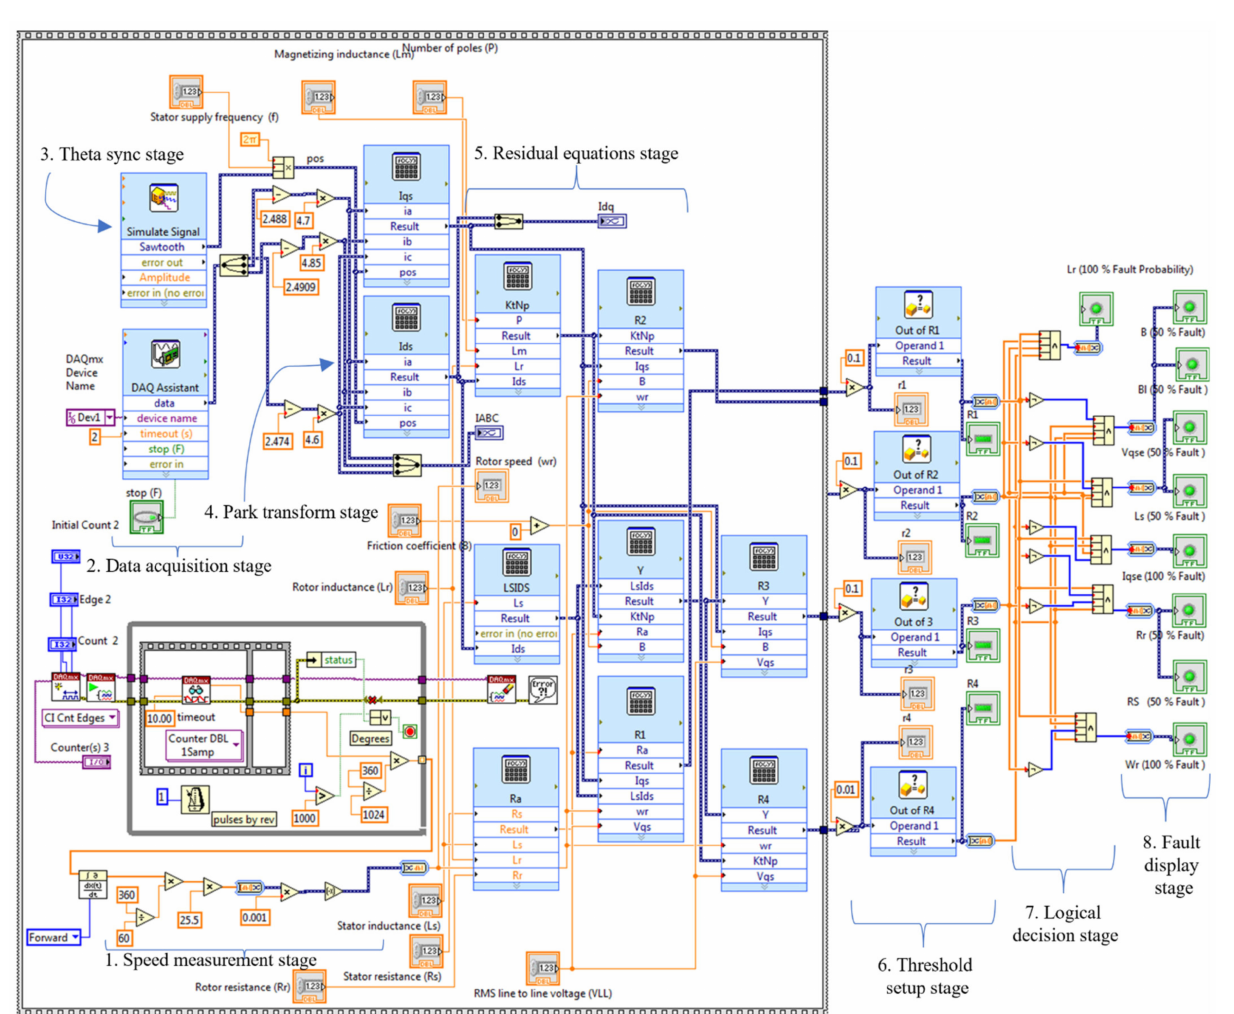
Figure 10. Fault detection algorithm implemented in